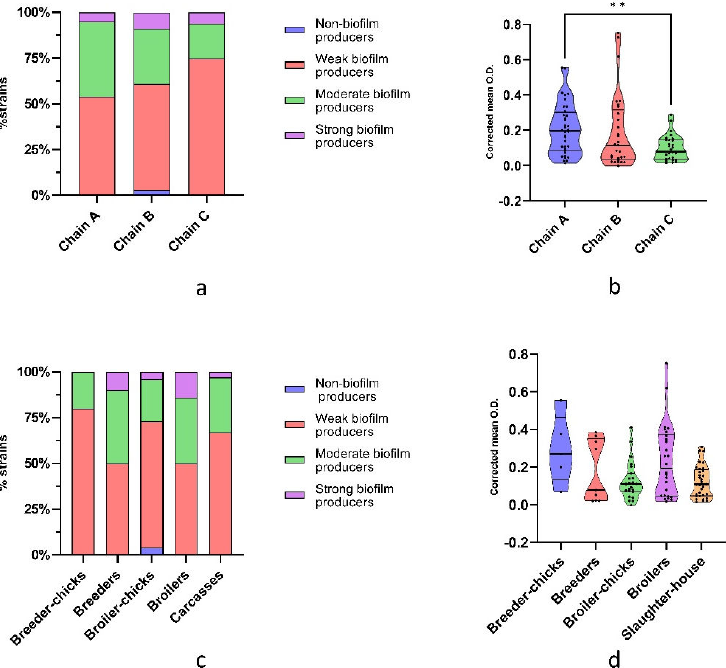
Figure 2. ( a ) Distribution of biofilm formation classes, presented as cumulative percentage of strains, and ( b ) corrected mean O.D. among production chains. ( c ) Distribution of biofilm formation classes, presented as cumulative percentage of strains, and ( d ) corrected mean O.D. among production stages. Lines within violin plots represent median, 25th, and 75th percentile. p < 0.01 is shown as